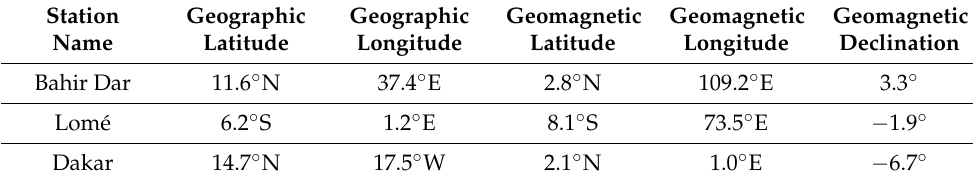
Table 1. GNSS observation sites in the east–west African